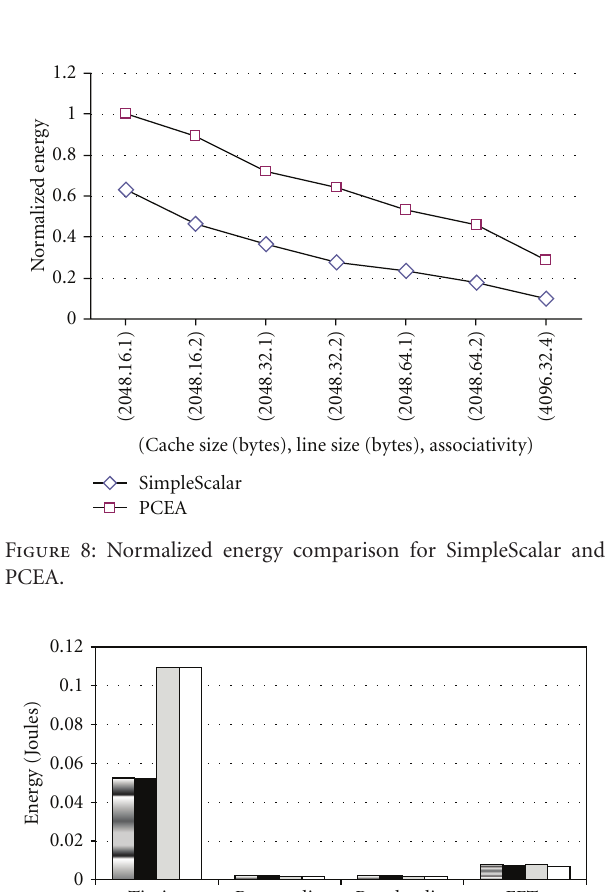
Figure 7: Energy estimation interactive chart.